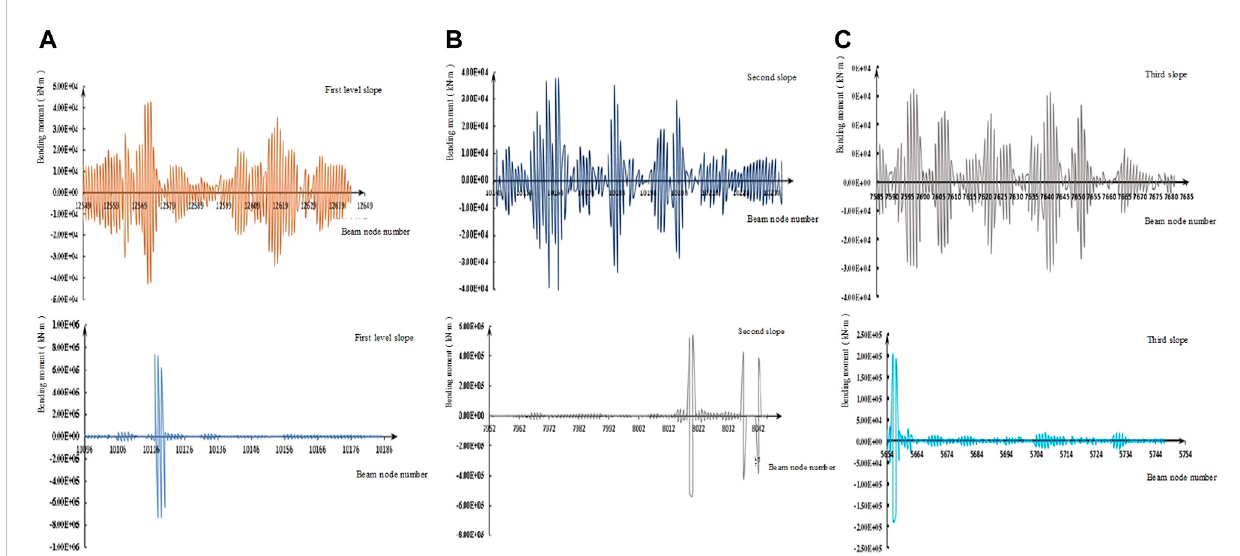
FIGURE 6 (A) BendingMomentDiagramofFrameBeamoftheFirstSlopebeforeandafterStructuralParameterOptimization; (B) BendingMomentDiagramof Frame Beam of the Second Slope before and after Structural Parameter Optimization; (C) Bending Moment Diagram of Frame Beam of the Third Slope before and after Structural Parameter Optimization (The fi rst line of pictures is before optimization, and the second line of pictures is after